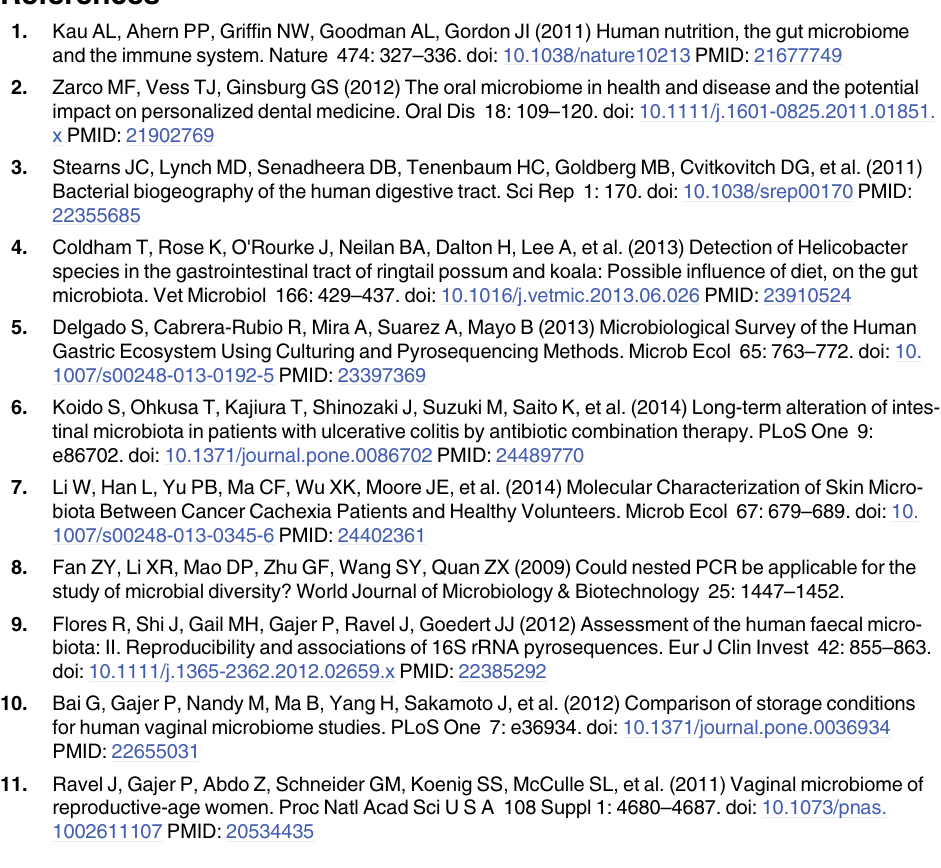
S1 Table. Difference between nested and standard PCRs in vaginal samples. S2 Table. List of discordant OTUs between nested_10 – 30 and standard PCRs; 2a), List of discordant OTUs between nested_10 – 30 and standard_40 for each vagina samples; 2b), List of discordant OTUs between nested_20 – 20 and standard_40 for each vagina samples; 2c), List of discordant OTUs between nested_10 – 30 and standard_40 for each stool sam- ples; 2d), List of discordant OTUs between nested_20 – 20 and standard_40 for each